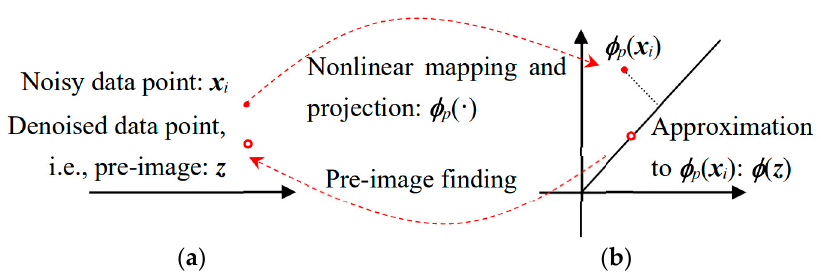
Figure 2. Denoising process used in this study: ( a ) Data in original space; ( b ) Data in transformed space.